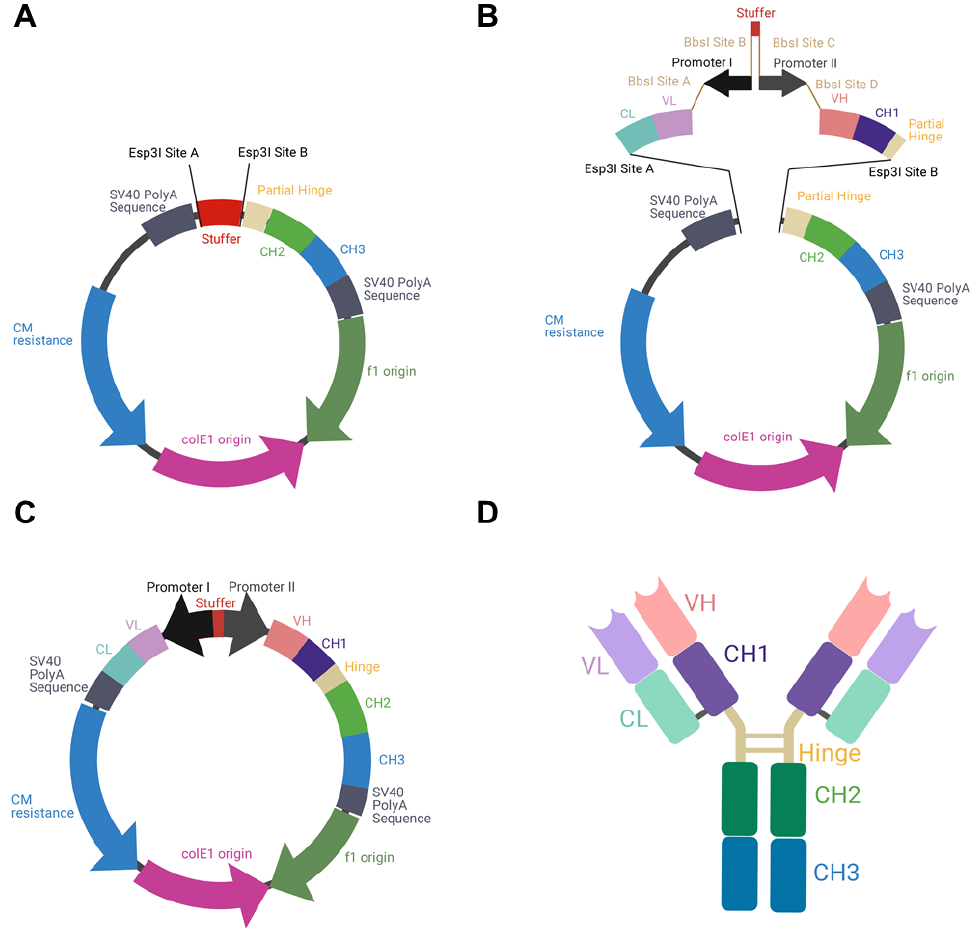
Figure 1. Schematic illustration of BiDi promoter system for antibody production. ( A ) The MD vector was designed to exhibit a 200-bp stuffer, flanked by Esp 3I restriction sites ( Esp 3I sites A and B), adjacent to a SV40 polyA signal sequence and the regions encoding for hinge-CH2-CH3, terminated by a SV40 polyA signal sequence. ( B ) VL-CL and VH-CH1 amplicons can be inserted into MD by Golden Gate cloning utilizing Esp 3I restriction sites ( Esp 3I sites A and B). The BiDi promoter can be chosen individually and is flanked by Bbs I sites ( Bbs I sites A–D), compatible with the VL and VH sequences. ( C ) Golden Gate assembly results in a fully functional and re-circularized vector, with the light chain under the control of promoter I and the heavy chain under the control of promoter II. ( D ) Schematic representation of the resulting heterotetrameric IgG1 antibody using the same colour code as for the genetic elements.